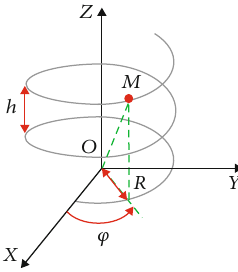
Figure 1: Geometric description of the helical